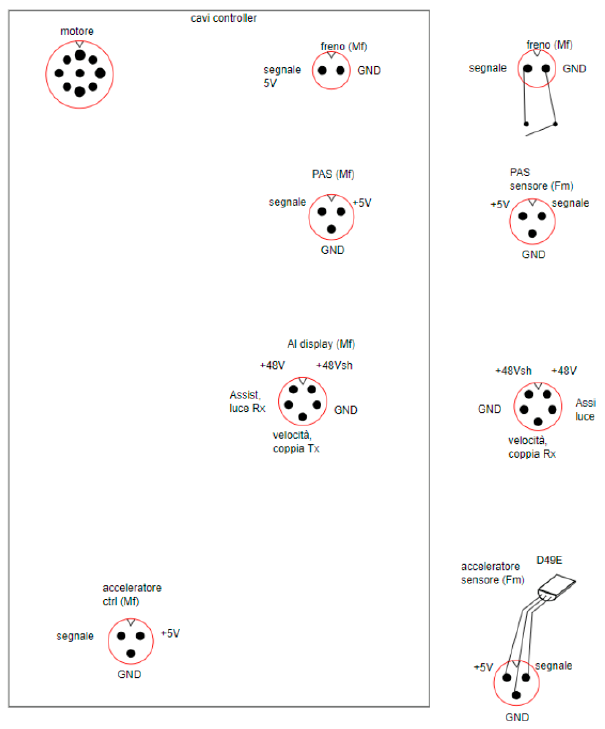
Figure 12. Pinout scheme of the controller connectors.